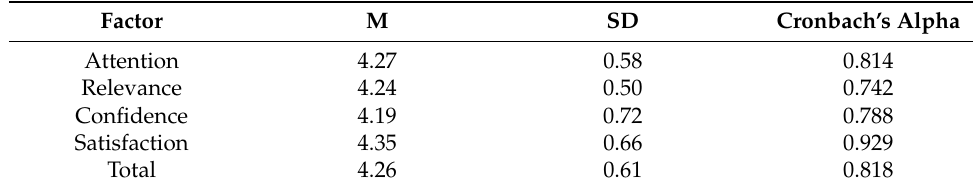
Table 4. Reliability analysis to each factor ARCS of IMMS.